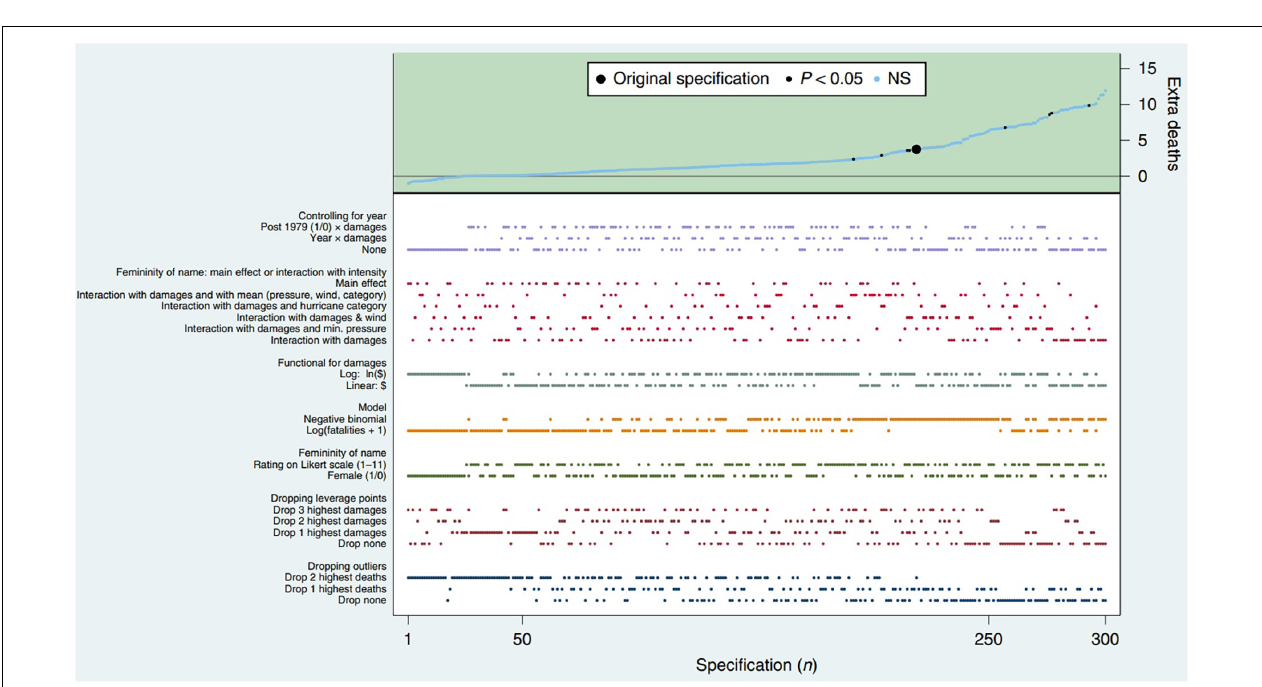
FIGURE 2 | Descriptive specification curve. Each dot in the top panel (green area) depicts the marginal effect, estimated at sample means, of a hurricane having a female rather than male name; the dots vertically aligned below (white area) indicate the analytical decisions behind those estimates. A total of 1,728 specifications were estimated; to facilitate visual inspection, the figure depicts the 50 highest and lowest point estimates and a random subset of 200 additional ones, but the inferential statistics for specification curve analysis include all 1,728 specifications. NS, not significant (Simonsohn et al., 2020, p. 3, Figure 2 ; reprinted with permission by the first